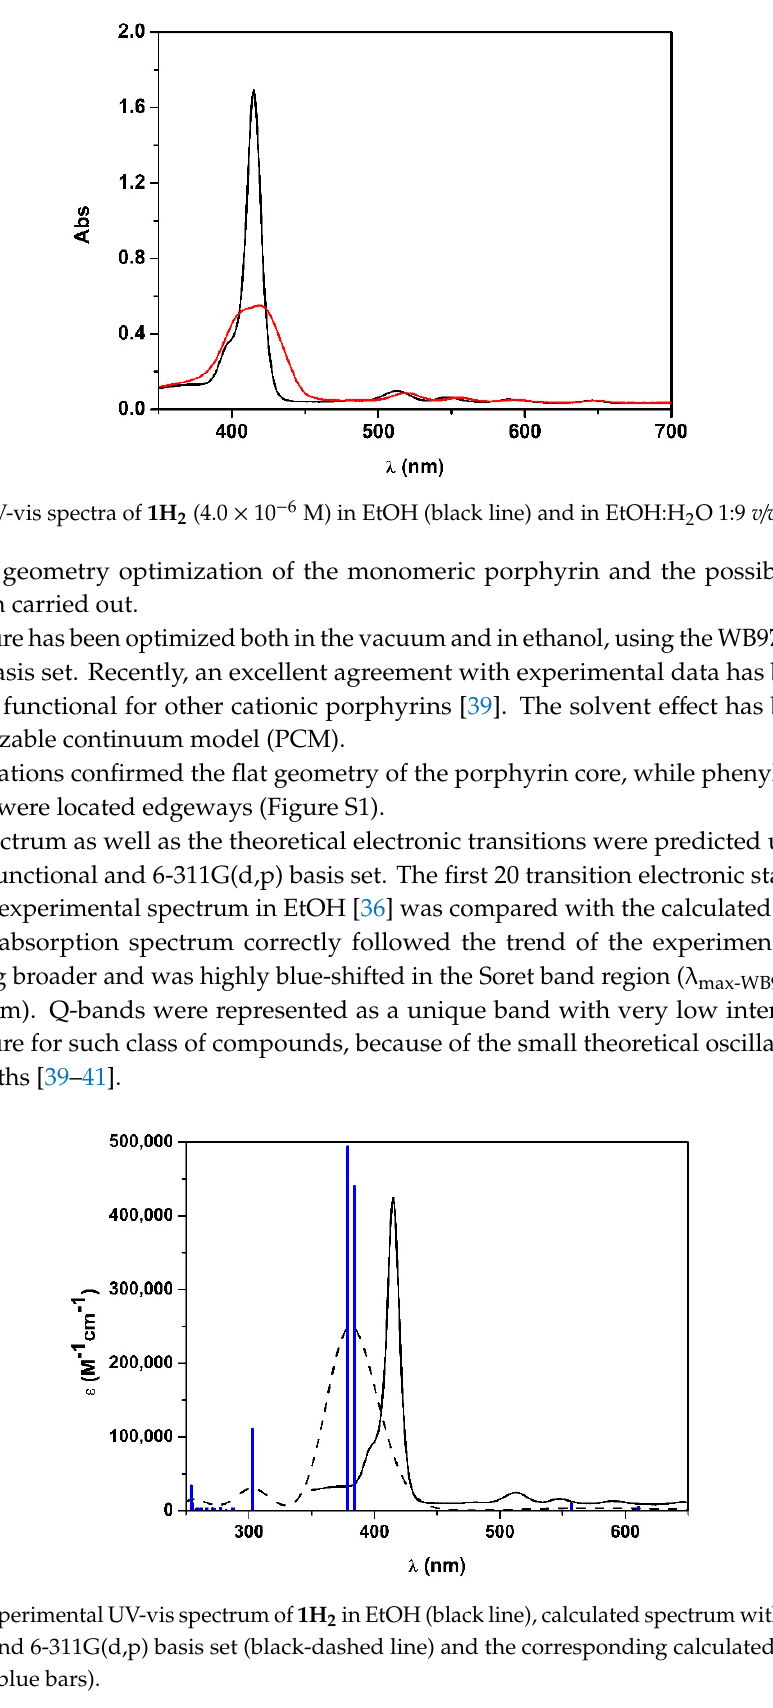
Figure 4. Calculated UV-vis spectra in EtOH of 1H 2 with: B3LYP functional 6-311G(d,p) basis set (green line), CAM-B3LYP functional 6-311G(d,p) basis set (red line), WB97XD functional 6-311G(d,p) basis set (blue line). Experimental UV-vis spectrum of 1H 2 in EtOH is represented with the black line. Results revealed that B3LYP and CAM-B3LYP better represent the absorption spectrum of 1H 2 in EtOH. Therefore, it can be assumed that WB97XD functional is suitable when a positive charge is delocalized over a π system, as previously observed [39,42]. Conversely, if the cation is located at the terminal position of a saturated alkyl side chain, and there is no interaction with the π-core , as in 1H 2 porphyrin, conventional functionals can be adopted. On this basis, B3LYP has also been chosen to visualize frontier orbitals. As typically observed for porphyrinoid systems, orbitals are delocalized over the porphyrin macrocycle (Figure 5), being responsible for π → π * transitions [39–41], while the positive-charged chain is not involved. HOMO-1 HOMO